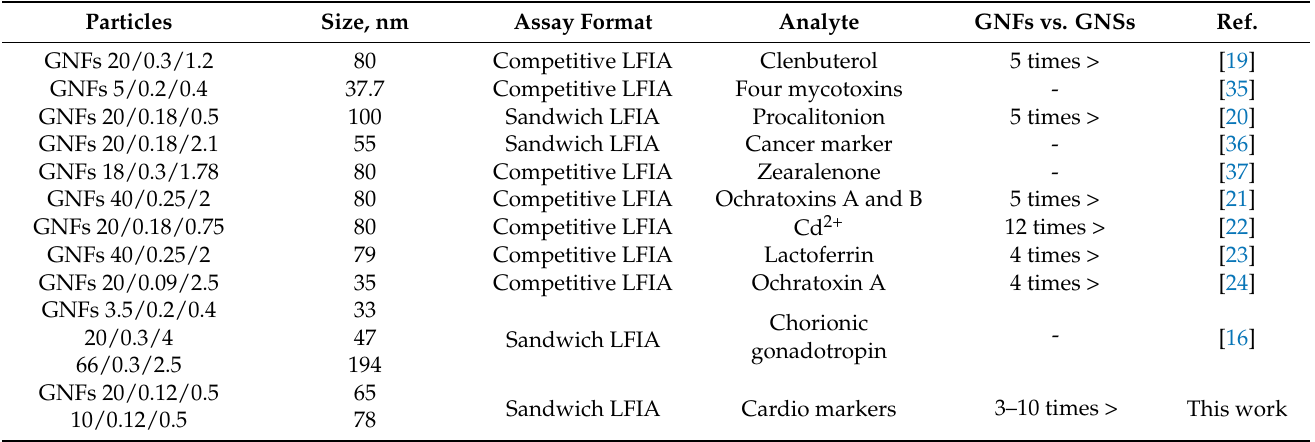
Table 5. The use of GNFs in